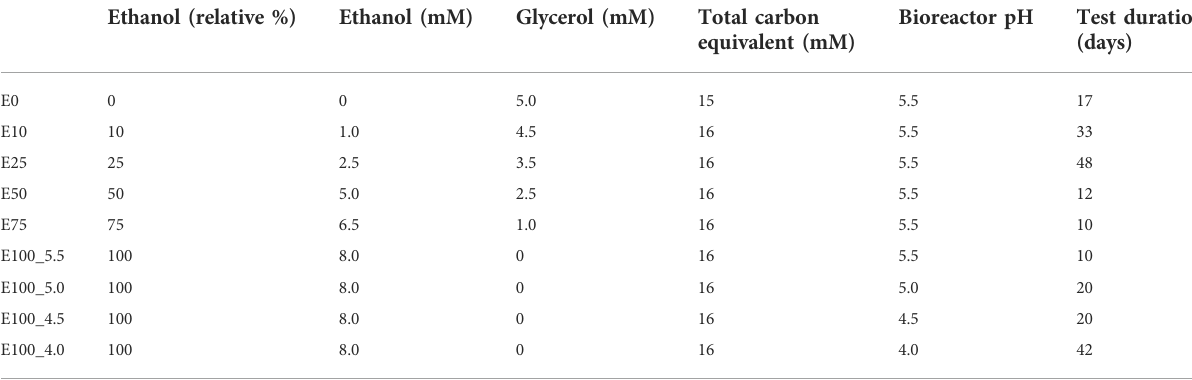
TABLE 2 Ratios of ethanol and glycerol in the in fl uent liquors and their combined carbon